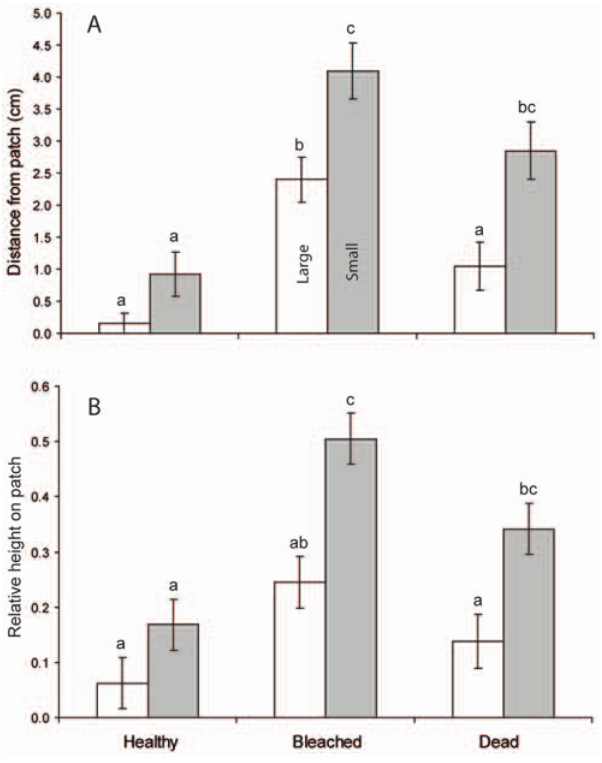
Figure 1. Influence of coral degradation on fish vulnerability. Spatial patterns of large and small Pomacentrus amboinensis (large is 0.8 to 1.0 mm larger than small) placed in pairs (one large, one small) onto patches of three hard coral habitat types (healthy, bleached and dead Pocillopora damicornis ). ( A ) mean horizontal distance from the patch reef recorded 30 min after release, and ( B ) mean relative height on the patch reef (a value of 1 represents 100% of time spent on top of patch; 0, 100% time at the base). Letters above the bars represent Tukey’s HSD groups. Errors are standard errors.